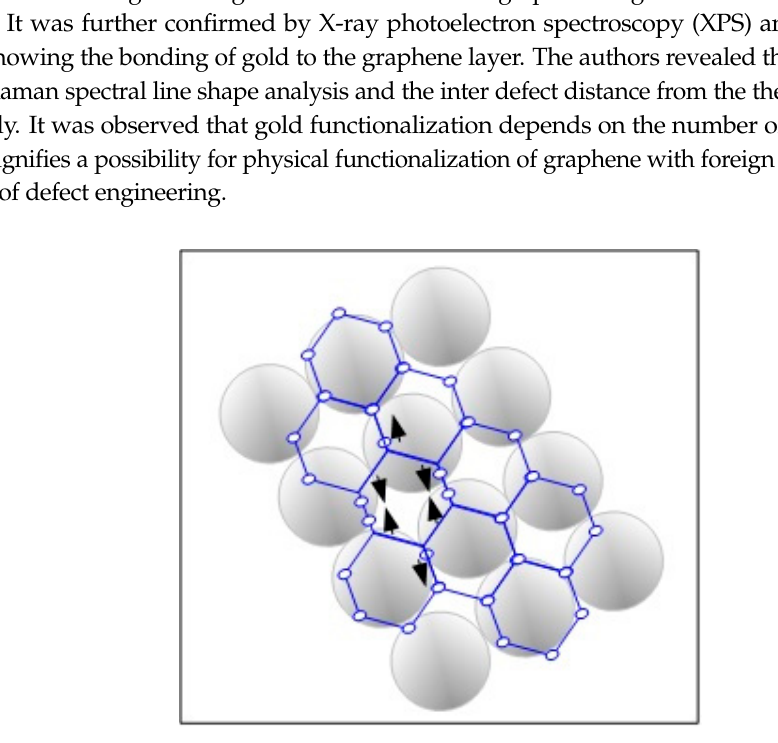
Figure 6. Graphene layer on gold showing the graphene–gold hybrid structure.